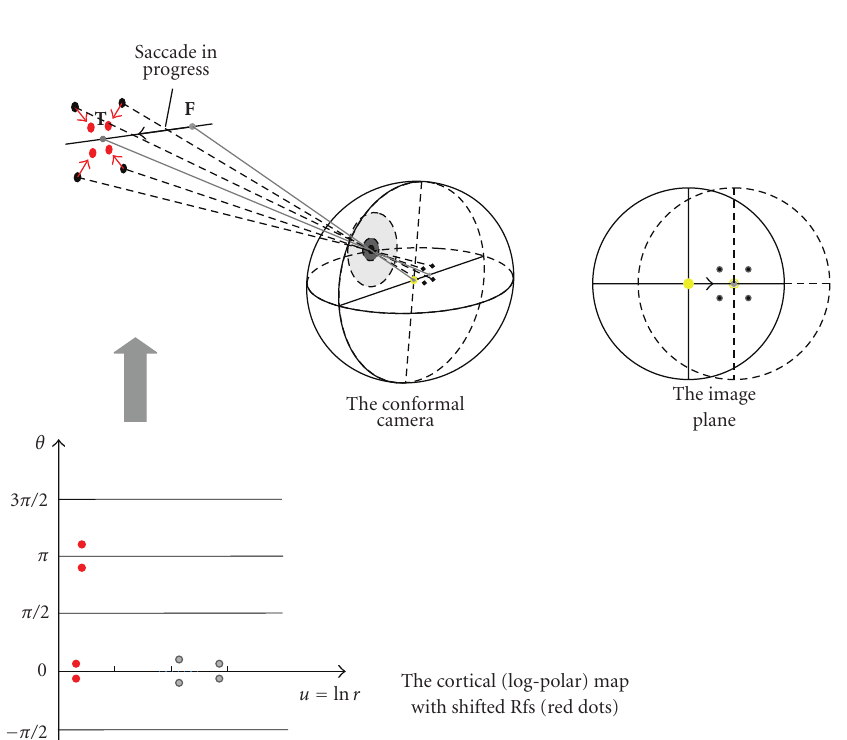
Figure 8: Perisaccadic compression of flashed probes perceived briefly during the saccadic eye movement. Note that this perception does not involve the visual sensory